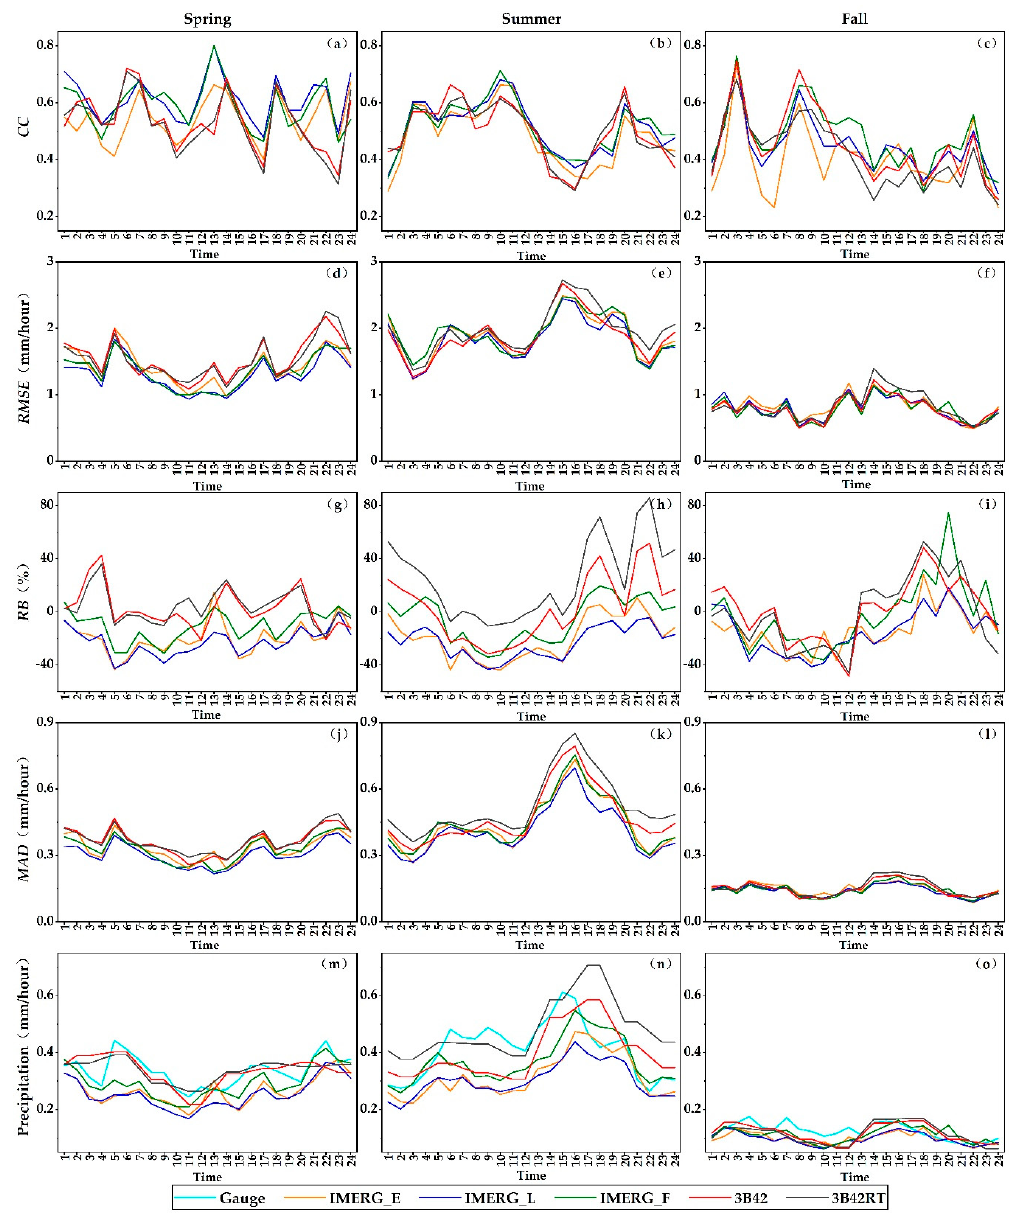
Figure 7. Changes in mean continuous metrics over a diurnal cycle in three seasons: ( a ) CC in spring; ( b ) CC in summer; ( c ) CC in fall; ( d ) RMSE in spring; ( e ) RMSE in summer; ( f ) RMSE in fall; ( g ) RB in spring; ( h ) RB in summer; ( i ) RB in fall; ( j ) MAD in spring; ( k ) MAD in summer; ( l ) MAD in fall; ( m ) average observed and estimated hourly rainfall in spring; ( n ) average observed and estimated hourly rainfall in summer; and ( o ) average observed and estimated hourly rainfall in fall.